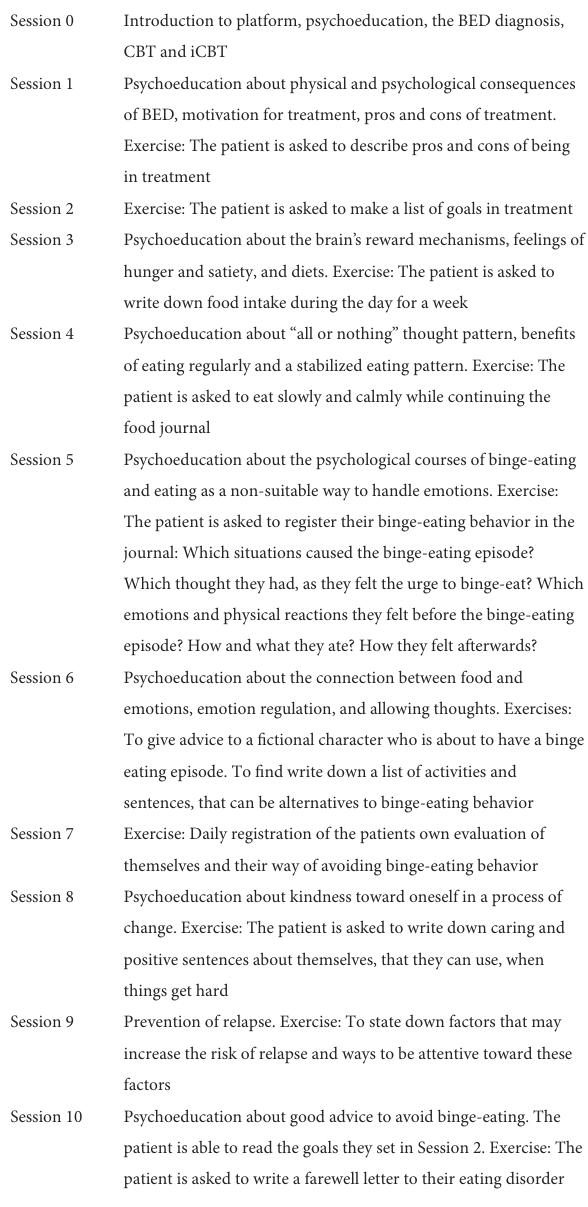
TABLE 1 The iBED program session